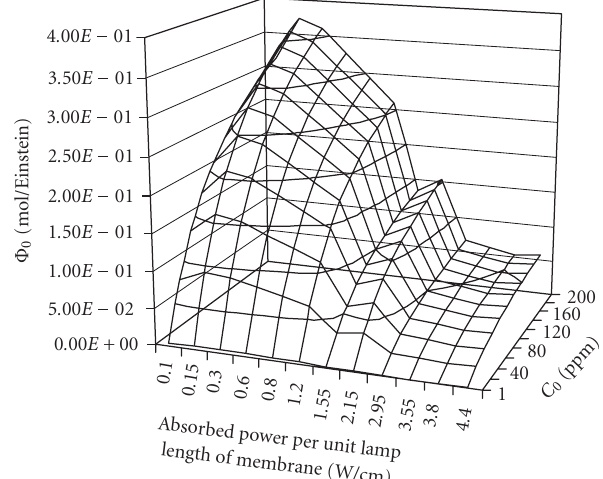
Figure 6: Quantum yields Φ 0 (mol of methane/Einstein) as a func- tion of initial concentration C 0 expressed as ppm (mass/volume) of carbon and of absorbed power per unit length of lamp (and mem- brane) expressed as Wcm − 1 .